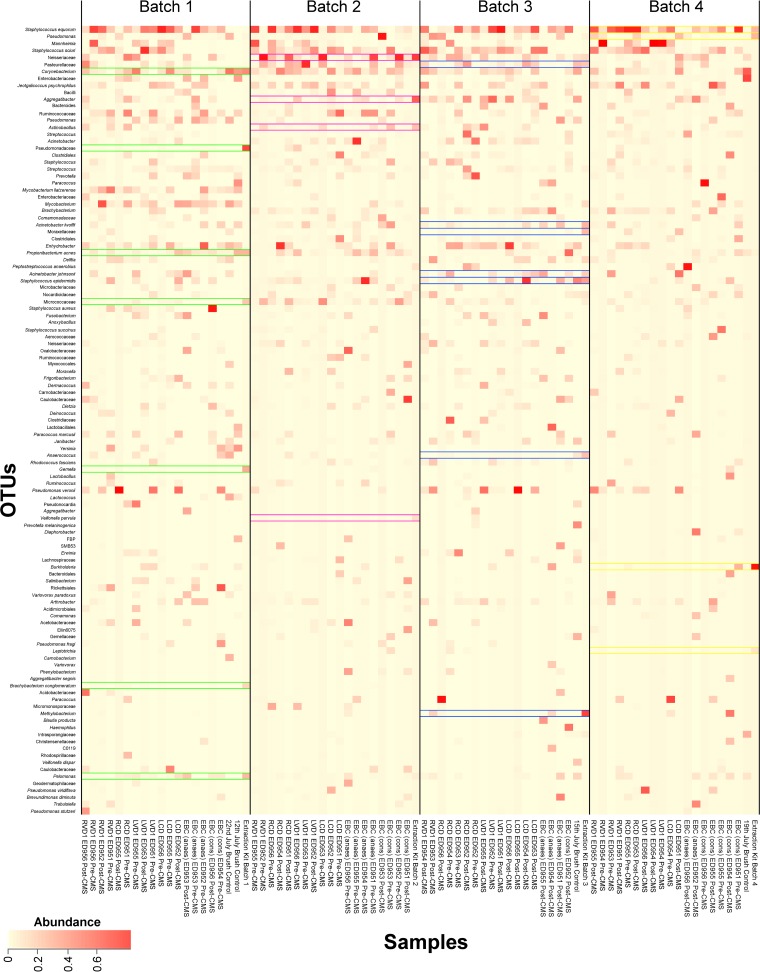
Heatmap showing samples grouped by batch based on the time DNA was extracted from the samples. Bacterial OTUs were included where they had an abundance of ≥5% in at least one sample. OTUs which were ≥5% abundant in a DNA extraction kit reagent control are indicated by color (batch 1, green; batch 2, pink; batch 3, blue; and batch 4, yellow). DNA extraction kit reagent controls are labeled as Extraction Kit Batch 1 to 4. EBC samples from conscious and from anesthetized sheep are labeled EBC (cons) and EBC (anaes), respectively. OTUs which were >5% abundant in an extraction kit control do not consistently appear in all samples in the same batch.